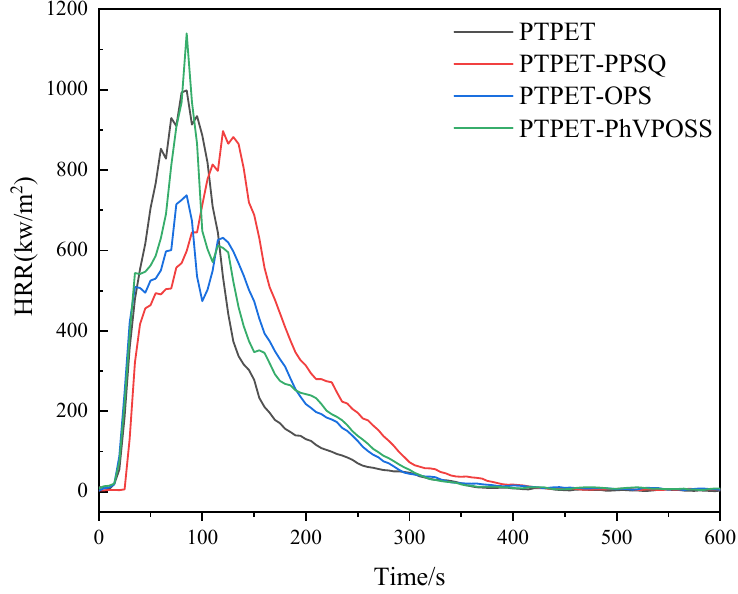
Figure 15. HRR curves of PTPET elastomer and composites.